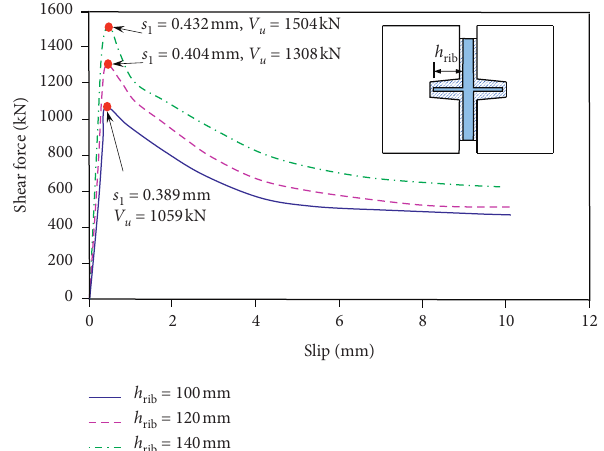
Figure 21: Influence of rib height on interface capacity.